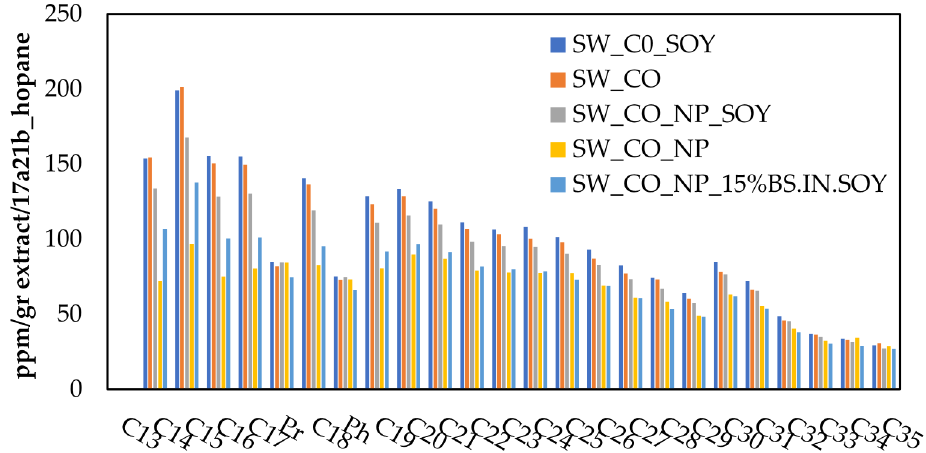
Figure 5. Bioremediation test results. Saturated hydrocarbons concentration after 28 days of bio- remediation (Cx are the saturated hydrocarbons, x is the number of carbons in the molecule, Pr: pristane and Ph: phytane). (a) SW_CO: Sea water with crude oil. (b) SW_CO_NP: Sea water, crude oil and N and P nutrients. (c) SW_CO_NP_BS: Sea water, crude oil, N and P nutrients and BS-in-dH 2 O 0.4% w/v.